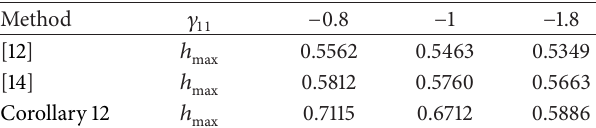
Table 1: The maximum allowable upper bound for different 𝛾 11 and time-invariant delay.